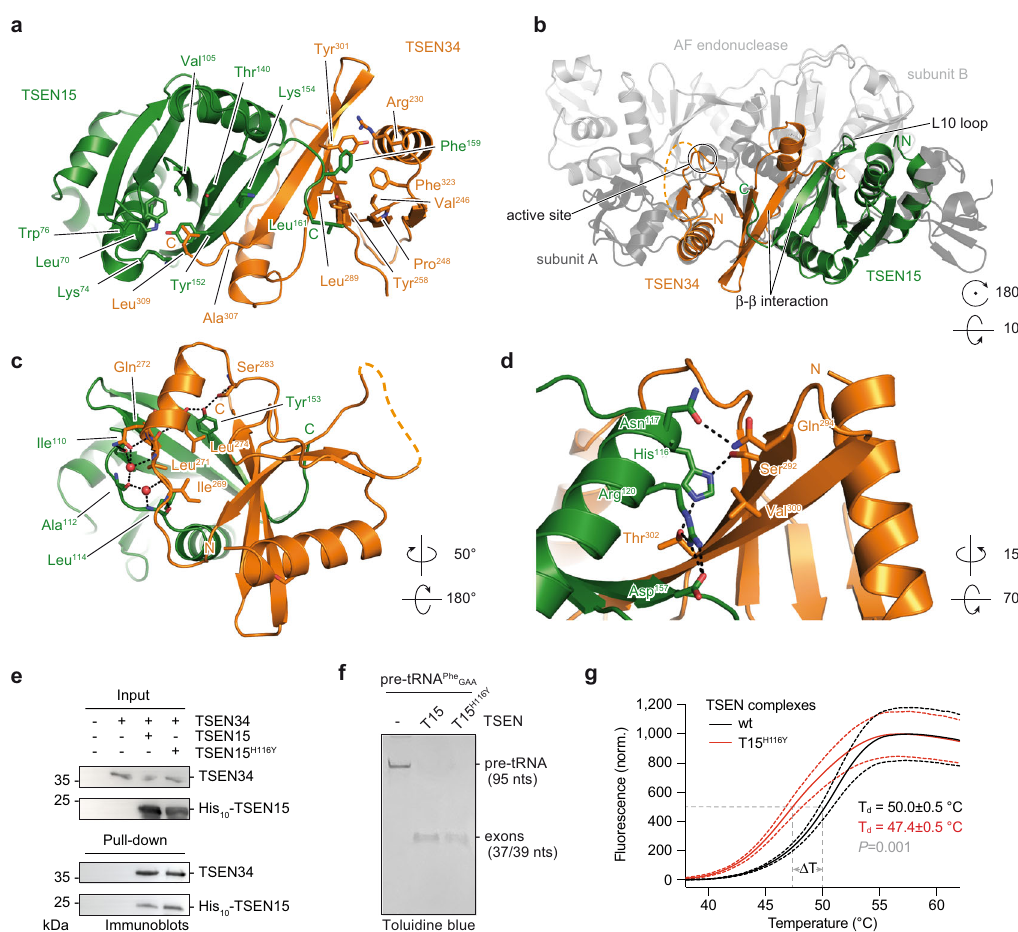
Fig. 3 Structural and functional details of the TSEN15 – 34 dimer interface. a X-ray crystal structure of a TSEN15 – 34 complex derived from limited proteolysis experiments. TSEN15 (green) and TSEN34 (orange) are shown in cartoon representation. Key amino acids are depicted in stick representation together with amino- (N) and carboxy (C)-termini. b Superposition of the TSEN15 – 34 heterodimer and the pre-tRNA endonuclease from Archaeoglobus fulgidus (AF) (PDB ID 2GJW) 13 . The position of the catalytic triad of TSEN34 (active site), the L10 loop of TSEN15, and the β -strands involved in the β - β interaction between TSEN15 and TSEN34 are shown. c Cartoon representation of the dimer interface with amino acid residues in stick representation (color coding as in a ). Water molecules and hydrogen bonds are shown as red spheres and black dashed lines, respectively. d Cartoon representation of the TSEN15 – 34 interface highlighting histidine 116 (His 116 ) of TSEN15, mutated in patients with a PCH type 2 phenotype. e Pull-down experiment with TSEN34, wt TSEN15, and TSEN15 carrying the H116Y mutation. Input and co-precipitated proteins were separated by SDS-PAGE and visualized by immunoblotting. Size markers and protein identities are shown. Blots are representative of two independent experiments. f Pre-tRNA cleavage assay with wt, tetrameric TSEN complex, and a tetrameric TSEN complex carrying the TSEN15 H116Y (T15 H116Y ) mutation. Cleavage products were separated by urea-PAGE and visualized with toluidine blue. Experiments are representative of two independent assays. g Thermal stability of wt, tetrameric TSEN (black line), and TSEN15 H116Y mutant complex (red line) assessed by differential scanning fl uorimetry (DSF). Note that recombinant complexes were puri fi ed from HEK293 cells. Normalized (norm.) fl uorescence is plotted against temperature in degree Celsius (°C). Denaturation temperatures (T d ) of the complexes were derived from sigmoidal Boltzmann fi ts (gray dashed lines) with an error of fi ts. Standard deviations (SD) of technical triplicates are represented by red (T15 H116Y ) and black (wt) dashed lines ( P = 0.001; unpaired, two-tailed Student´s t -test). Source data for e and f are provided as Source Data fi